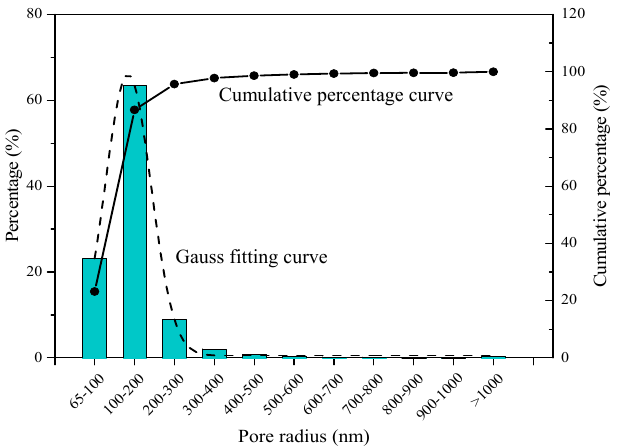
Figure 8. Pore quantity distribution at the nano–scale.